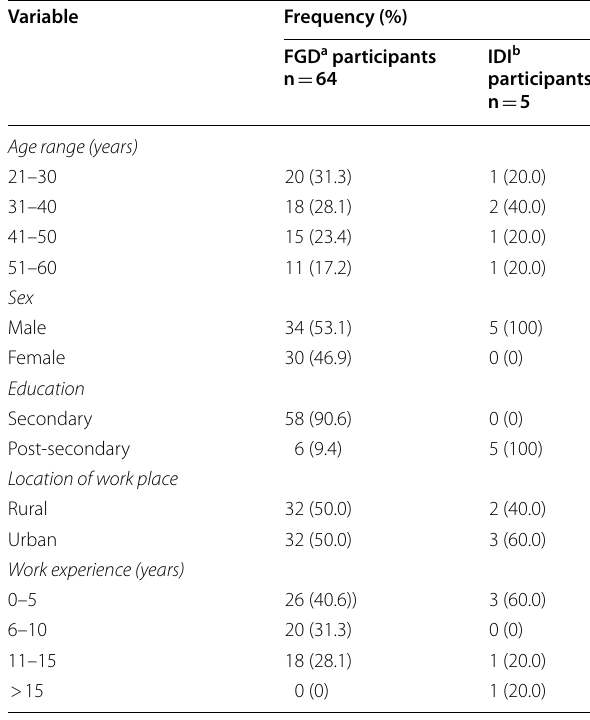
Table 1 Sociodemographic characteristics of the